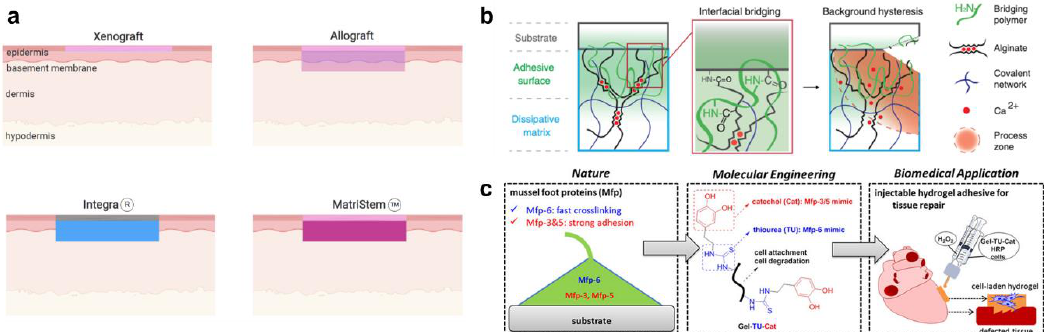
Figure 3. ( a ) Di ff erent wound covers and regeneration templates [ ? ]. ( b ) Dual-layer hydrogel adhesives inspired by slugs. From [ ? ]. Reprinted with permission from the American Association for the Advancement of Science ( c ) Injectable adhesives inspired by mussel foot proteins. Reprinted with permission from [ ? ]. Copyright 2019 American Chemical